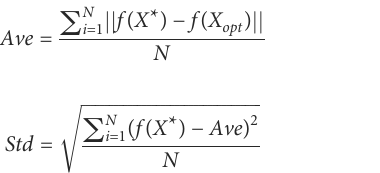
Table 2. The optimization accuracy of the algorithm is the absolute value of the error between the actual optimal solution and the theoretical optimal solution. In this paper, the average ( Ave ) and standard deviation ( Std ) of the optimization accuracy are used to re fl ect the convergence accuracy and stability of the algorithm. The calculation formula is as follows: